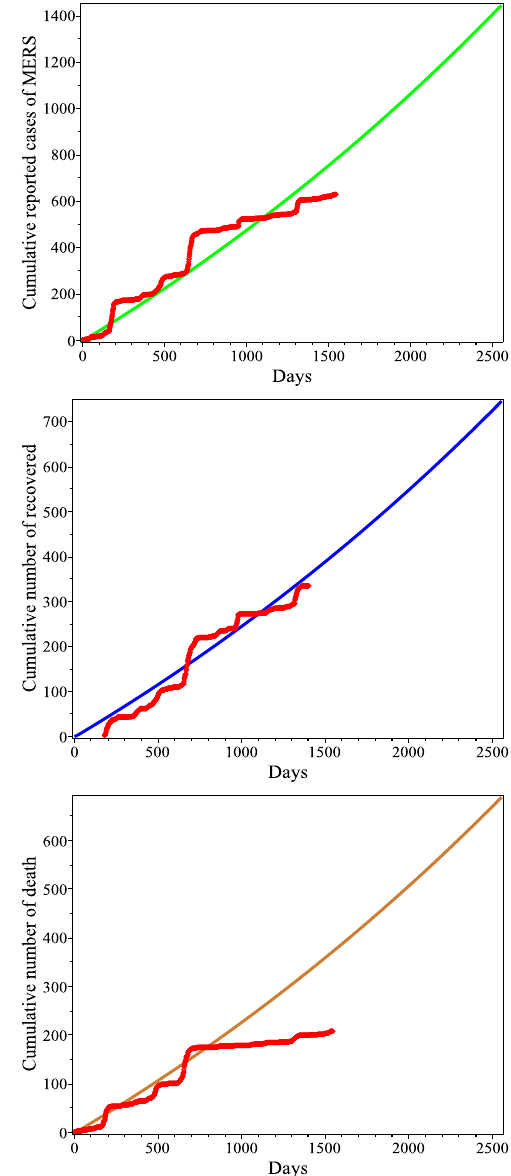
Fig. 6: Riyadh simulations with R c = 1 . 0045 . Cu- mulative cases of MERS (T), cumulative number of recovered (M), and cumulative number of death (B). The red dots are the field data. The run was for 2555 days ( ∼ 84